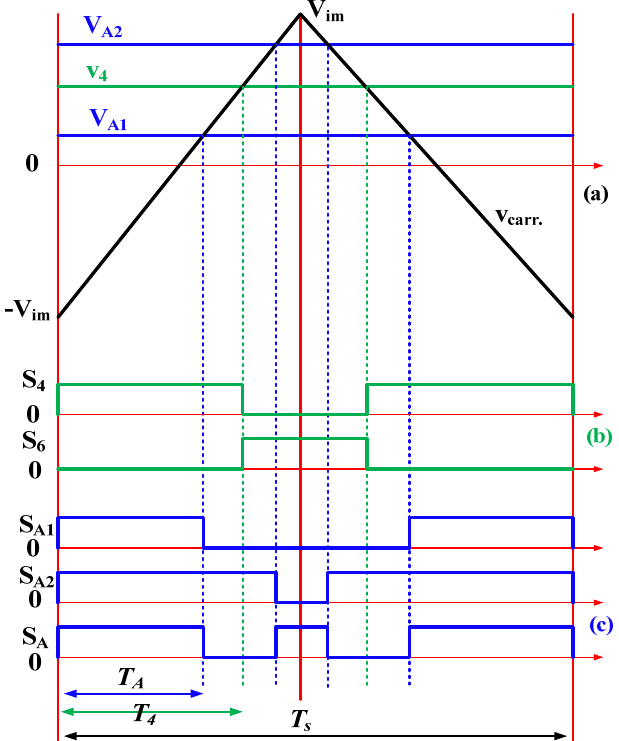
Figure 4. (a) Carrier and modulation signals, (b) the duty cycle of rectifier and (c) inverter in sector 1 using CBPWM.